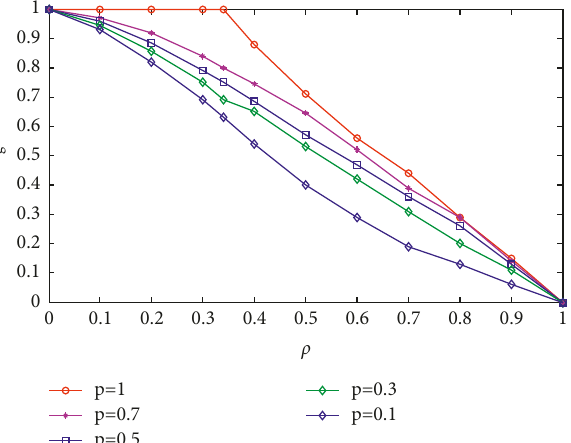
Figure 2: The relation between average velocity and density when p � p